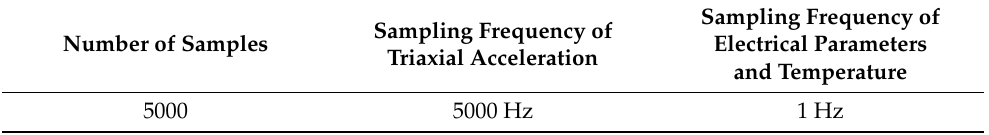
Table 1. Relevant parameters of data